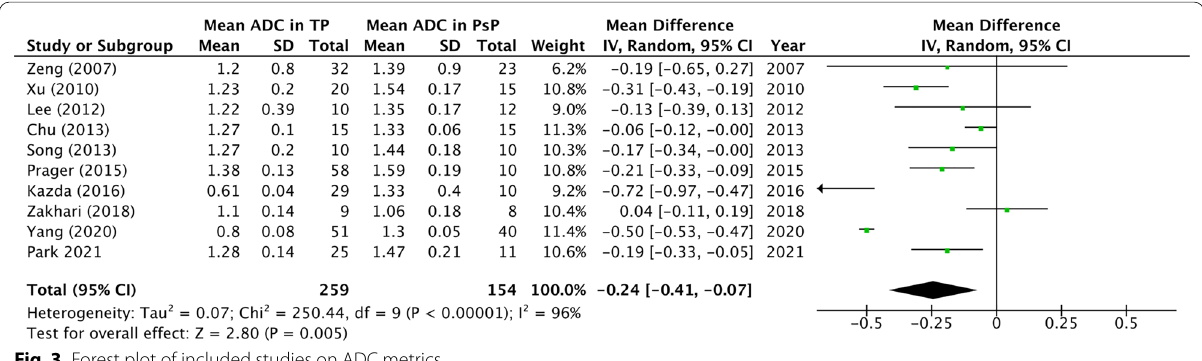
Fig. 3 Forest plot of included studies on ADC